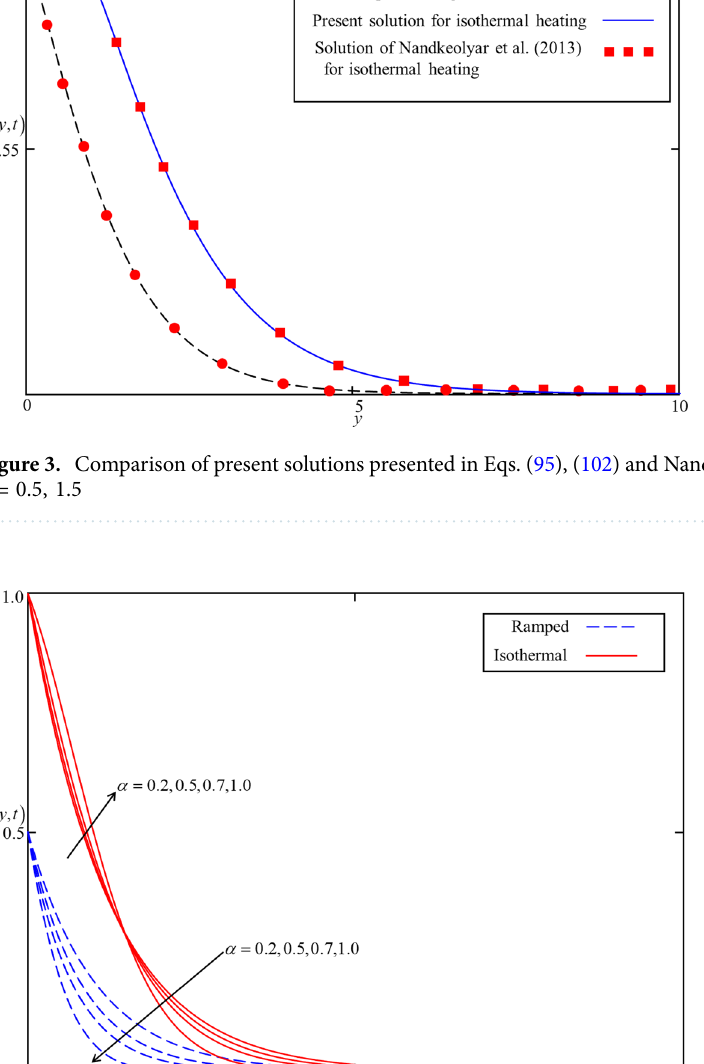
Figure 4. Consequence of α on θ